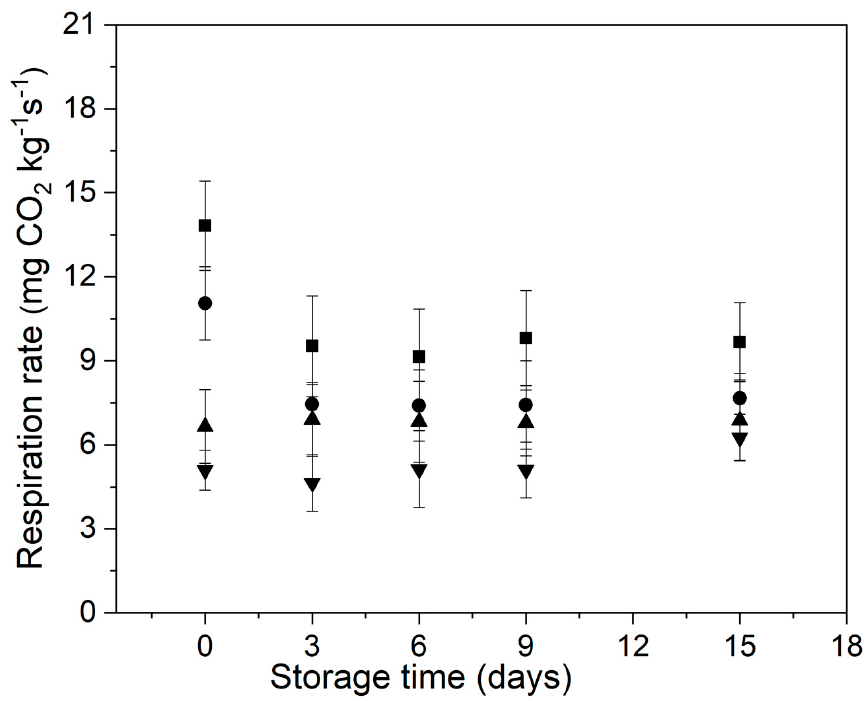
Figure 1. Behavior of the respiration rate of control and treated minimally processed bunching green onions during storage. Control ( ■ ); mild-heat treatment ( ● ); edible coating ( ▲ ); mild-heat treatment+ edible coating ( ▼ ).